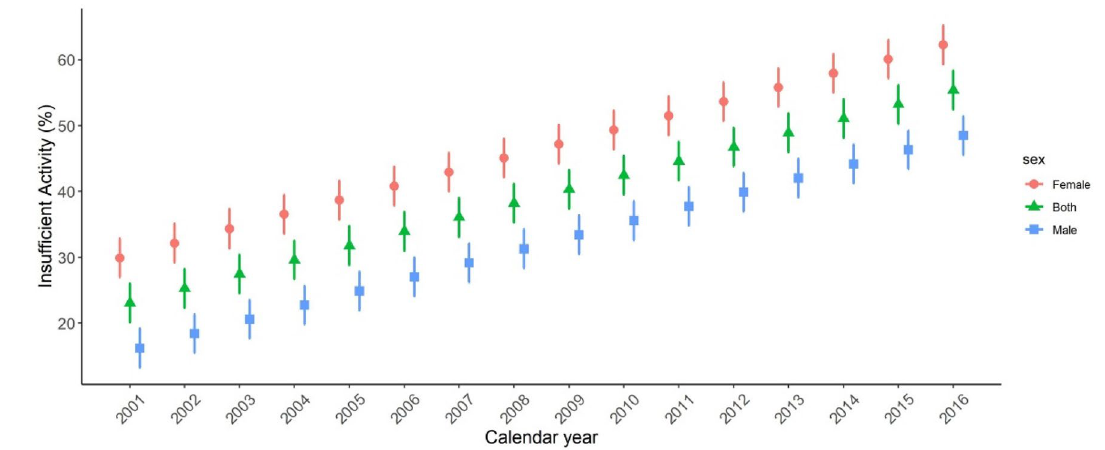
Figure 1. The trend of IPA from 2001 to 2016 is demonstrated below for male, female, and both genders. The lines represent 95% UI of IPA prevalence in each time point. IPA: insufficient physical activity; 95% UI: 95% ucertainty